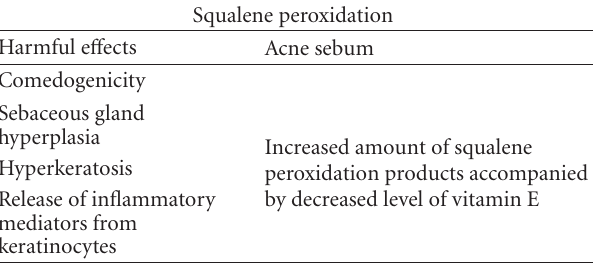
Table 2: Harmful e ff ects of squalene peroxidation . The adverse e ff ects of squalene peroxidation products and in particular of squalene monohydroperoxide have been assessed both in vitro and in vivo. Moreover, sebum from acne patients seems to have high level of squalene